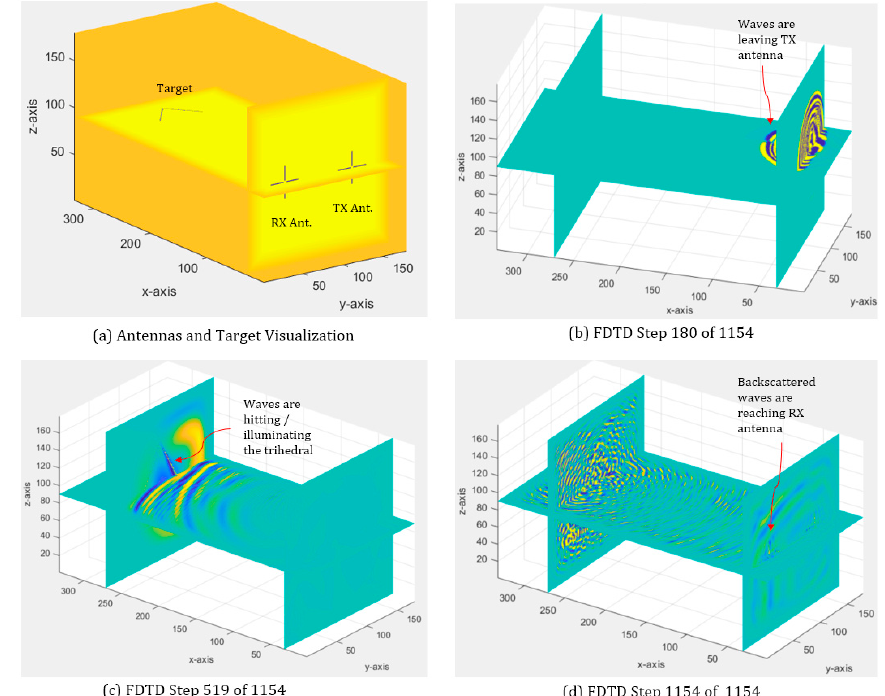
Figure 7. Visualization during a simulation (trihedral corner reflector, 3 GHz, RR, θ = 0 ◦ , φ = 0 ◦ ). The 3D volume is visualized by applying a horizontal cutting plane and two vertical cutting planes: ( a ) Antennas and target visualization before the Finite-Difference Time-Domain (FDTD) calculation started, where each TX and RX antenna set consisted of a horizontal and a vertical dipole antenna. ( b – d ) show the FDTD states respectively at steps 180, 519, and 1154 of 1154.